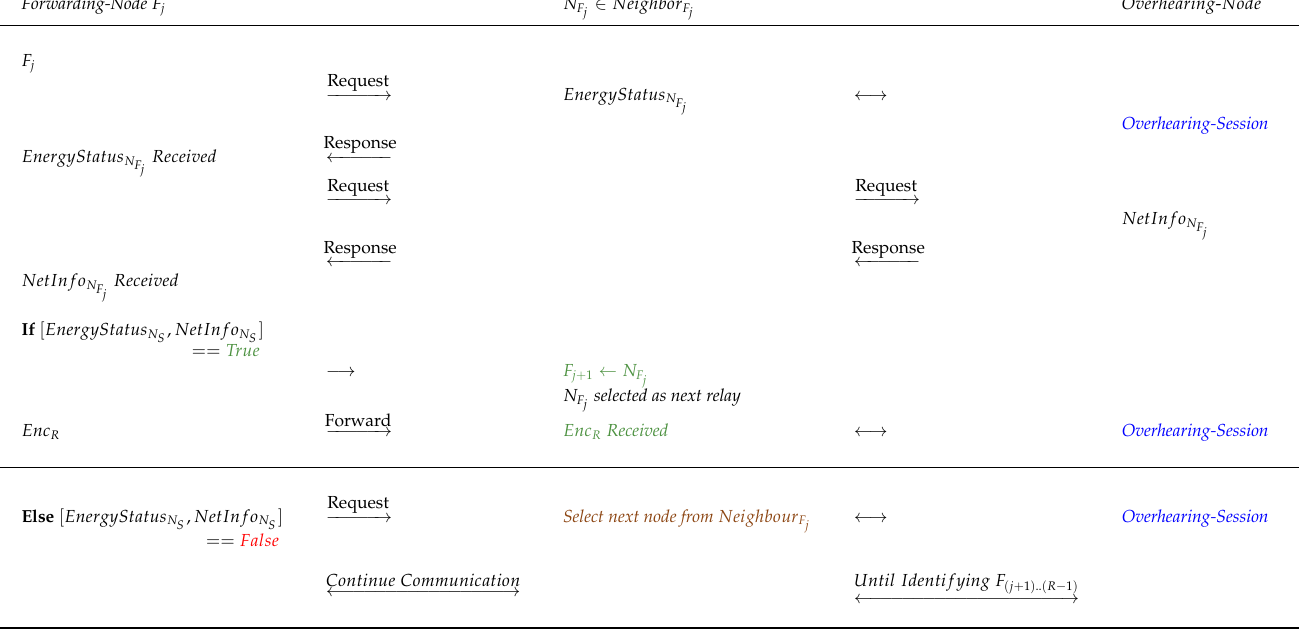
Figure 4. Selfish node—energy